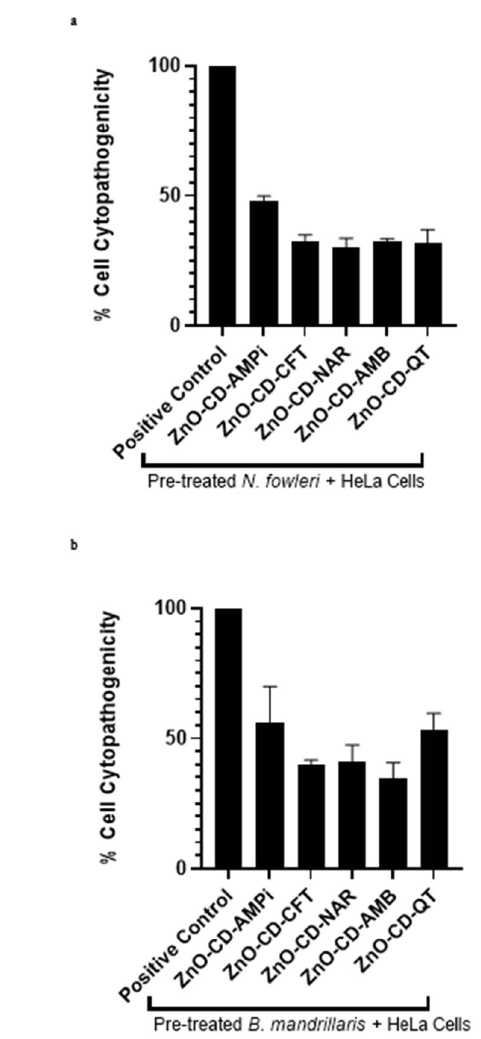
Figure 3. All compounds led to a decrease in amoeba-mediated cytotoxicity in human cells. ( a ) All compounds reduced N. fowleri -mediated cytotoxic activity and ( b ) B. mandrillaris -mediated cytotoxic activity in human cells. After treatment with 100 µ g/mL of the compounds for 2 h, 2 × 10 5 amoebae were placed on HeLa cell monolayers overnight, and their cytotoxicity was measured the following